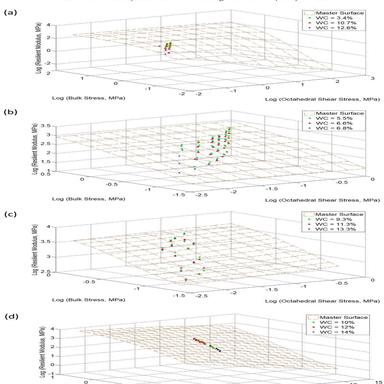
Examples of MR Master Surface Development Before Horizontally Shifting Data a) YSSG Subgrade, b) GLAB2 Granular Base, c) MSF2 Stabilized Material, and d) RPCC Recycled Material.